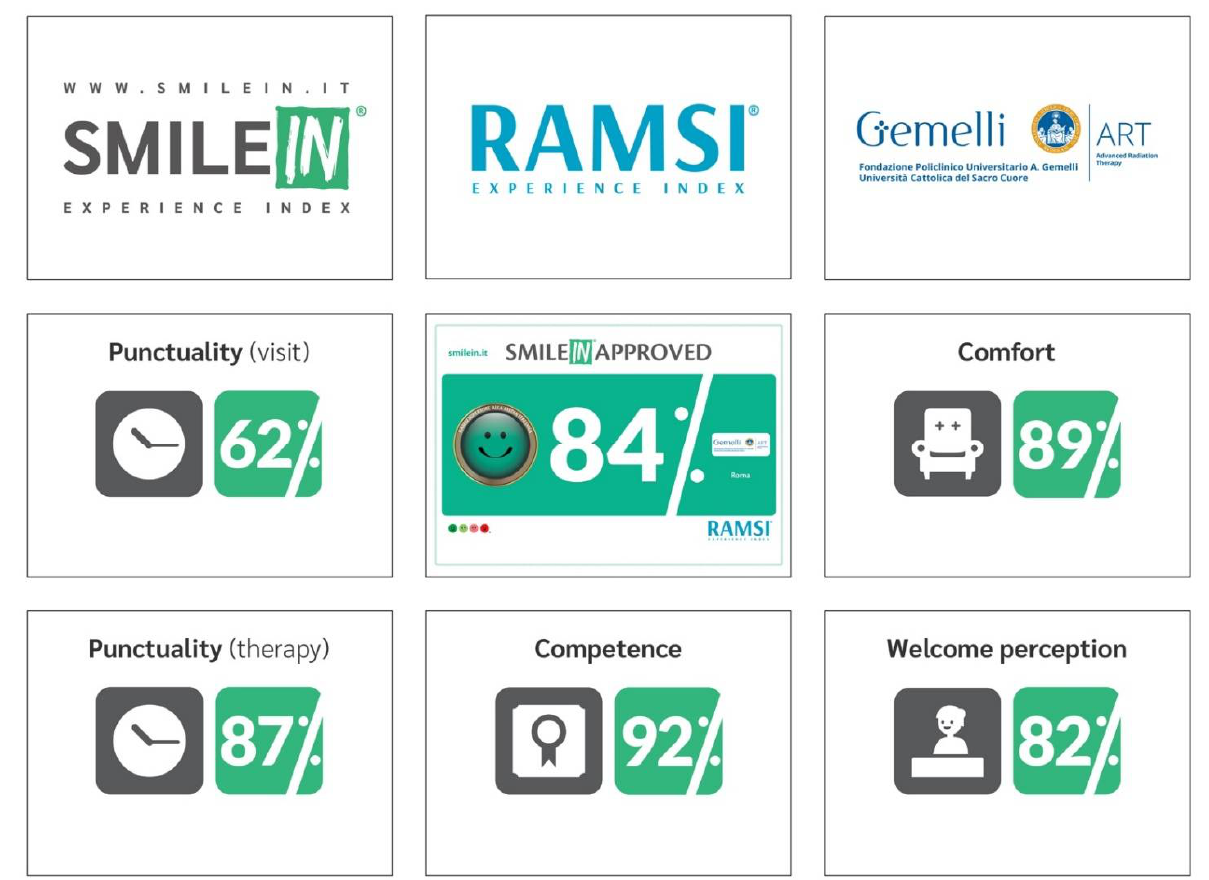
Figure 1. Monthly SmileIN approved.